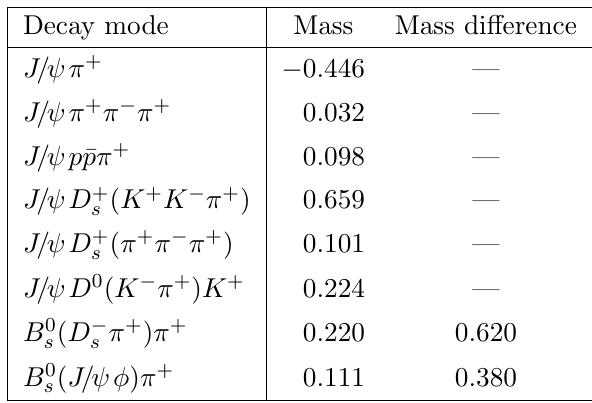
Table 6. Weights of the decay modes in the combination of the B + ence (cid:1) M .